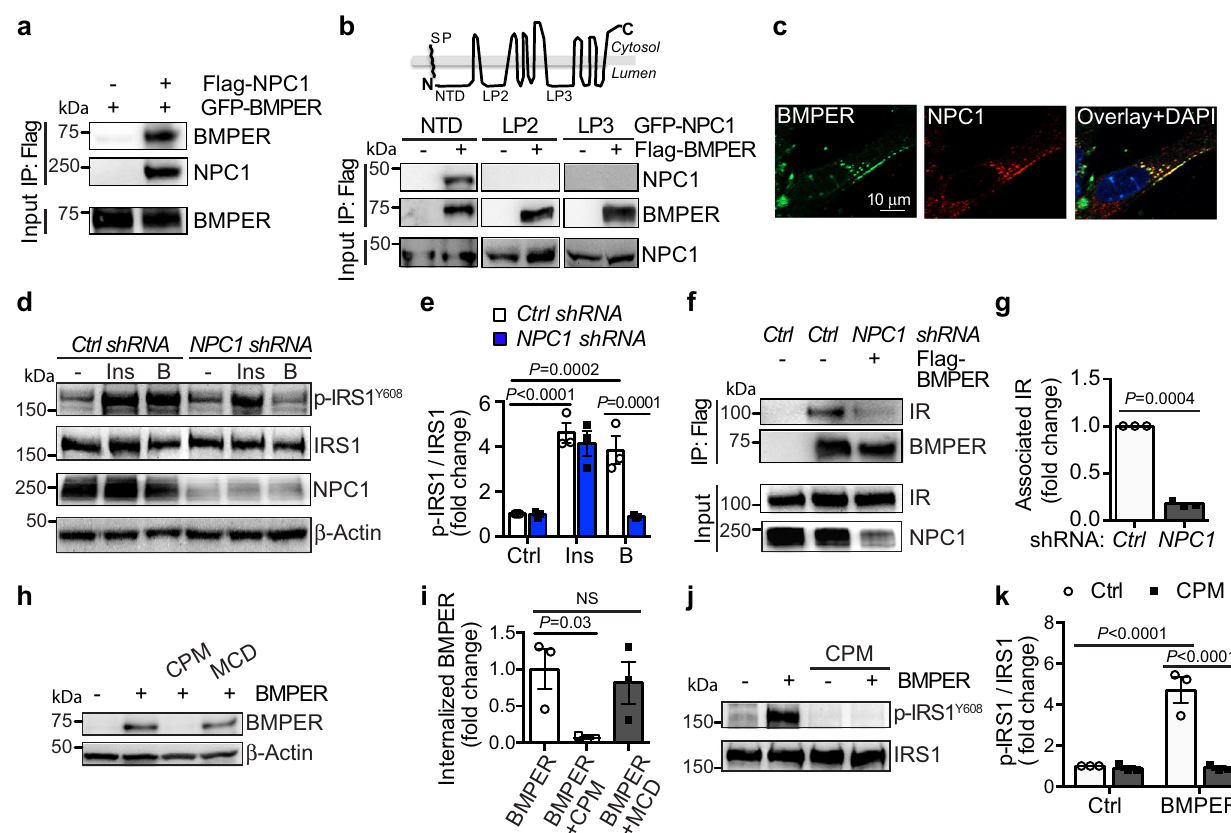
Fig. 5 BMPER promotes insulin signaling through NPC1 and endocytosis. a Co-immunoprecipitation (IP) of GFP-tagged BMPER and fl ag-tagged NPC1 in HEK293 cells. b Co-immunoprecipitation of GFP-tagged NPC1 constructs containing different lumenal domains (NTD, N-terminal domain, a.a. 25-164; LP2, loop 2, a.a. 371-615; LP3, loop 3, a.a. 855-1098) and fl ag-tagged BMPER in HEK293 cells. SP signal peptide. c Hepatocytes were treated with fl